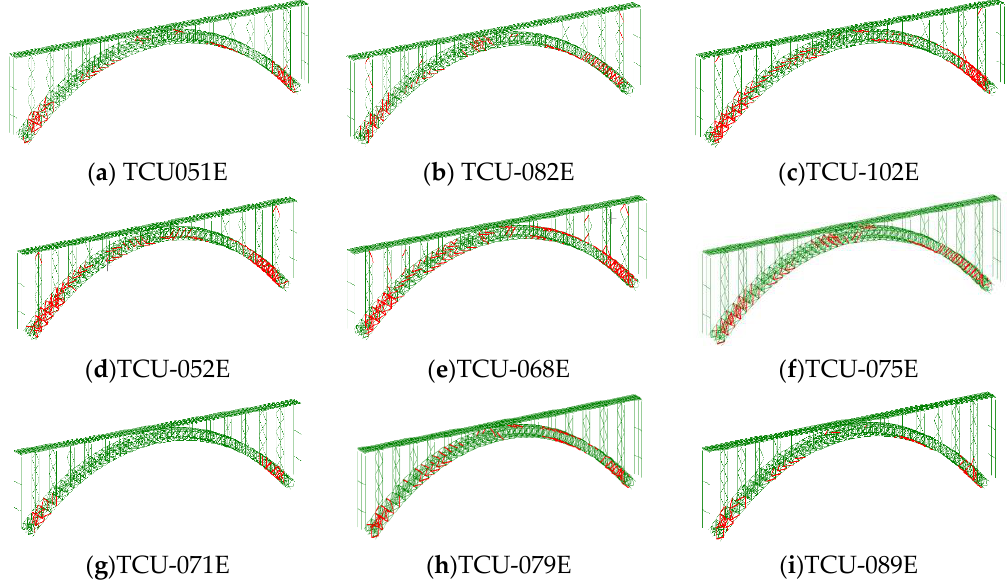
Figure 7. Distribution of buckling members under rare ground motion. Note: elements in red are the braces where flexural damage occur.